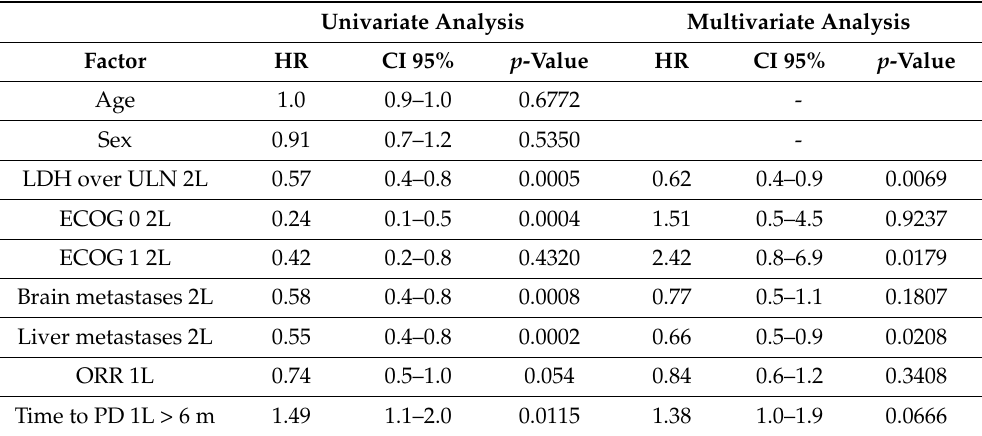
Figure 3. Overall survival of melanoma patients since initiation of second line nivolumab or pembrolizumab treatment. (OS on nivolumab was 6.6 months, and on pembrolizumab was 5.0 months; p = 0.99). Groups treated with nivolumab and pembrolizumab did not differ in baseline subgroup characteristics based on LDH level ( p = 0.99), gender ( p = 0.19), age ( p = 0.31), or presence of brain metastases ( p = 0.59). The presence of liver metastases, lower performance status (ECOG1), and high LDH activity correlated with PSF on second line immunotherapy ( p = 0.0208, p = 0.0179 and p = 0.0069, respectively) in the whole group (Table 3, Figure 4). Table 3. Factors that influence median PFS on second line immunotherapy in advanced metastatic melanoma patients.